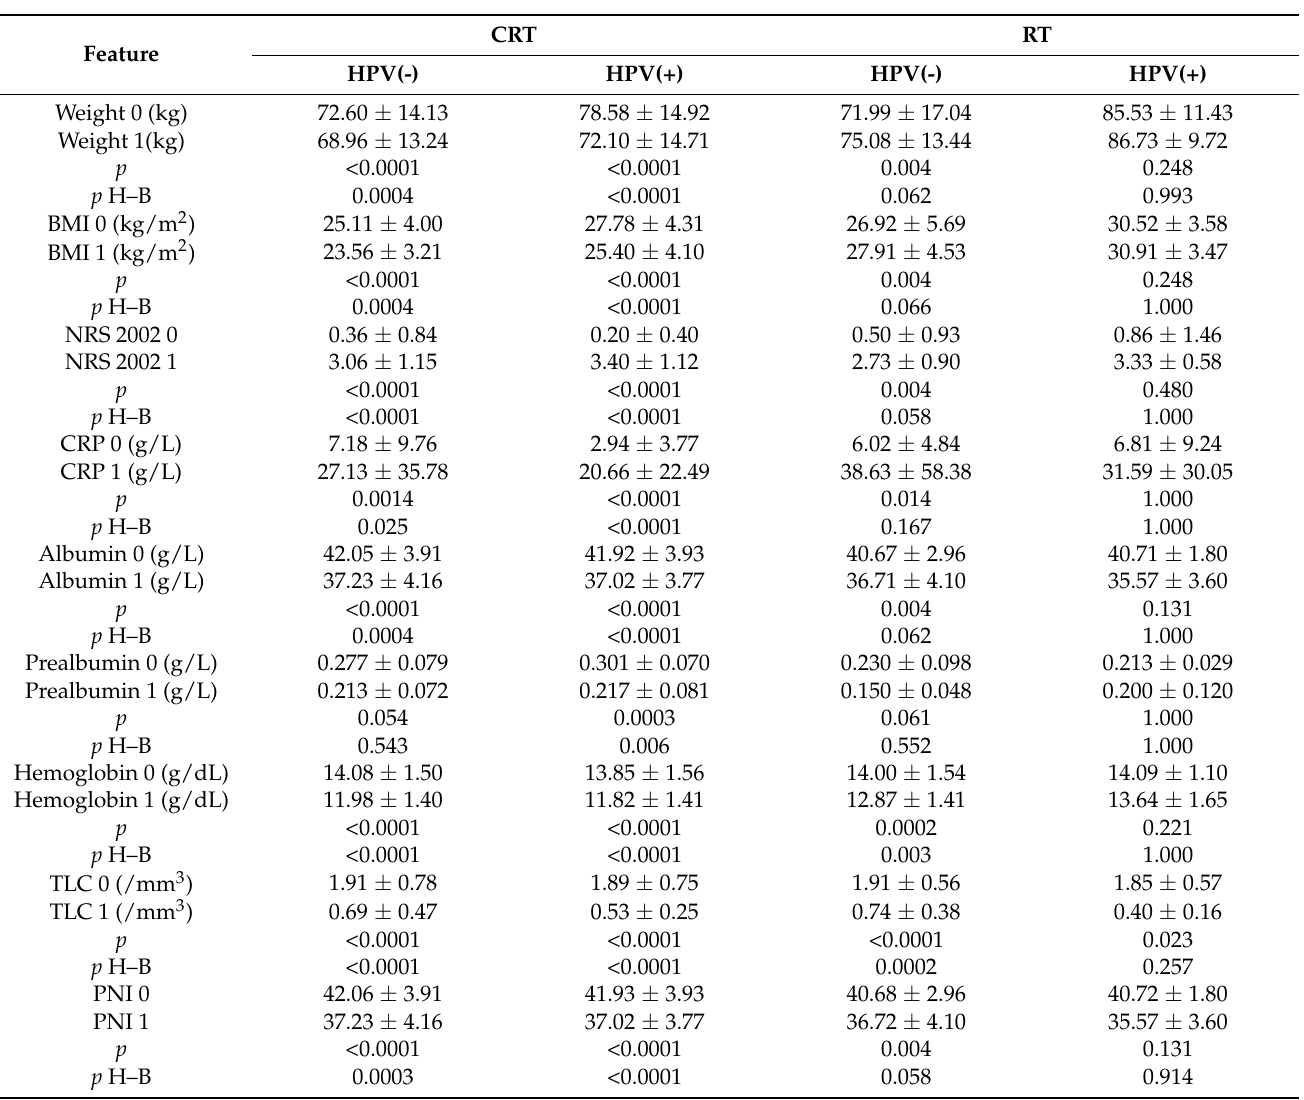
Table 5. Weight, BMI, and laboratory results before and after treatment in the HPV- and HPV+ groups undergoing RT and CRT separately (comparison between HPV